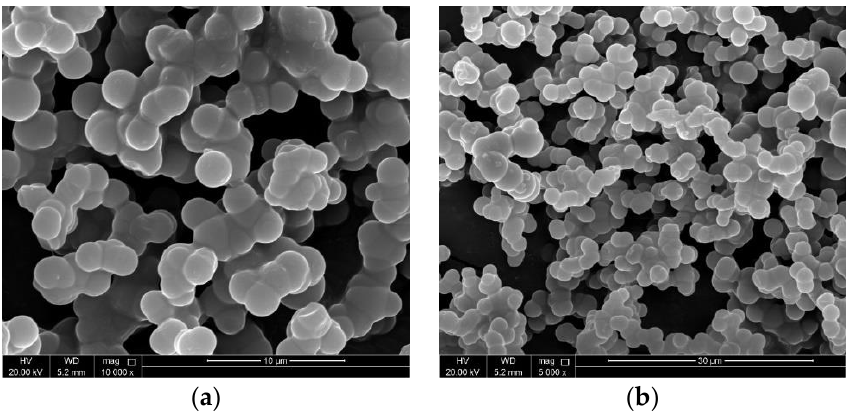
Figure 4. Trial-3 (1.50 g AOT) microcapsule SEM images for scales of ( a ) 10 µm and ( b ) 30 µm.